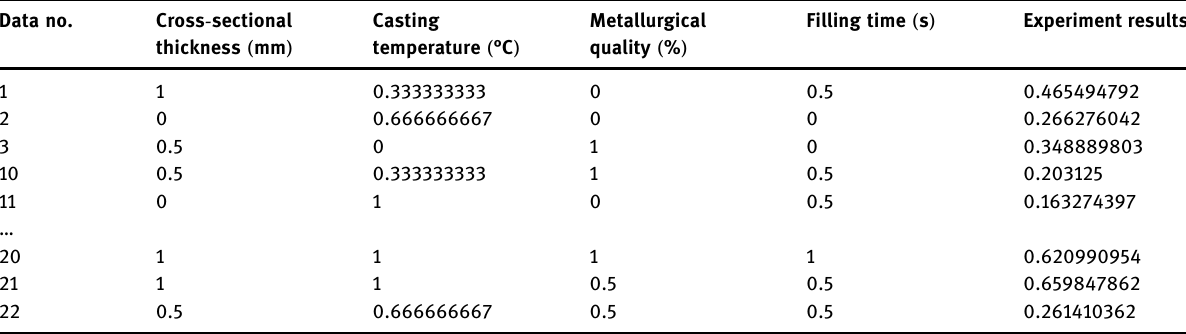
Table 5: An example section of the normalized test set Data